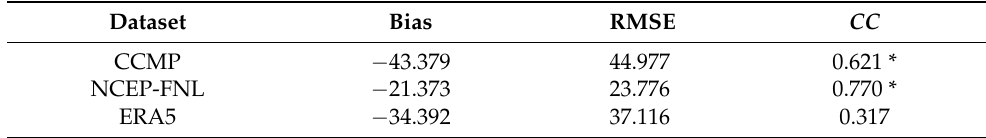
Table 2. Statistics on surface wind evaluation (unit: m · s − 1 ). The base dataset is idealized wind vortex. The comparisons are performed during typhoon period. The asterisk in CC represents the CC passing 0.05 significant